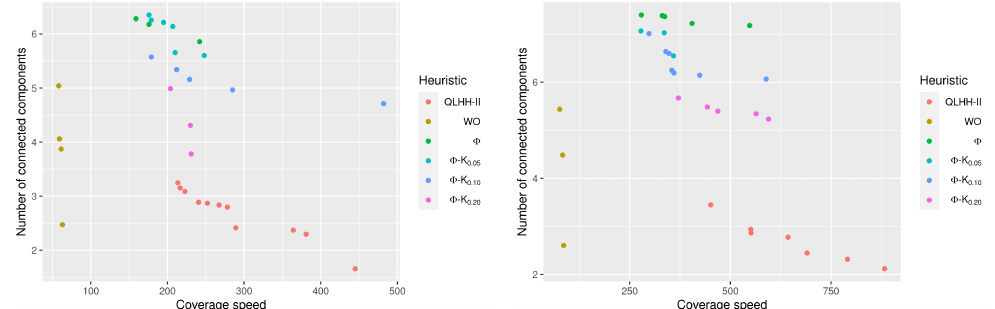
Figure 10. Example of fronts obtained with different heuristics for two instances, from the classes (20 × 20/10) on the left and (25 × 25/10) on the right